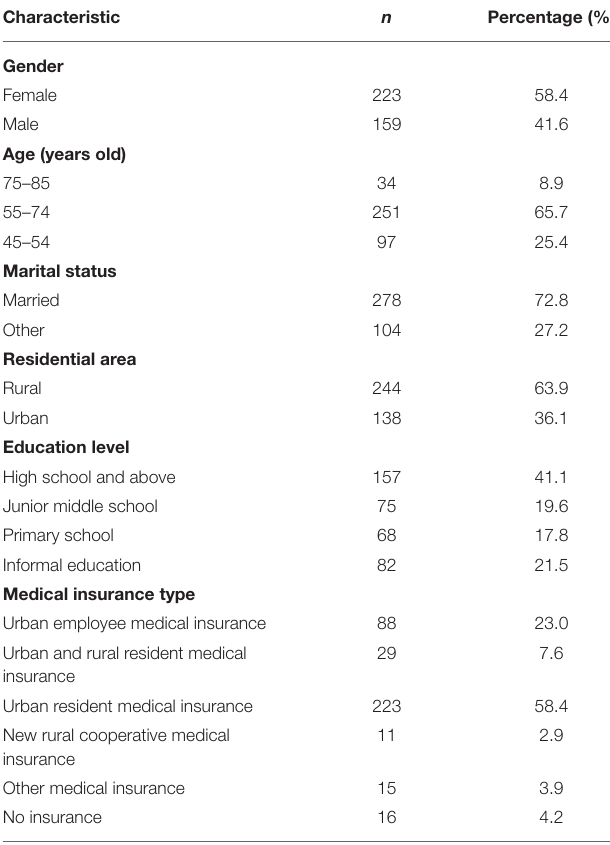
TABLE 1 | Characteristics of the sample ( N =